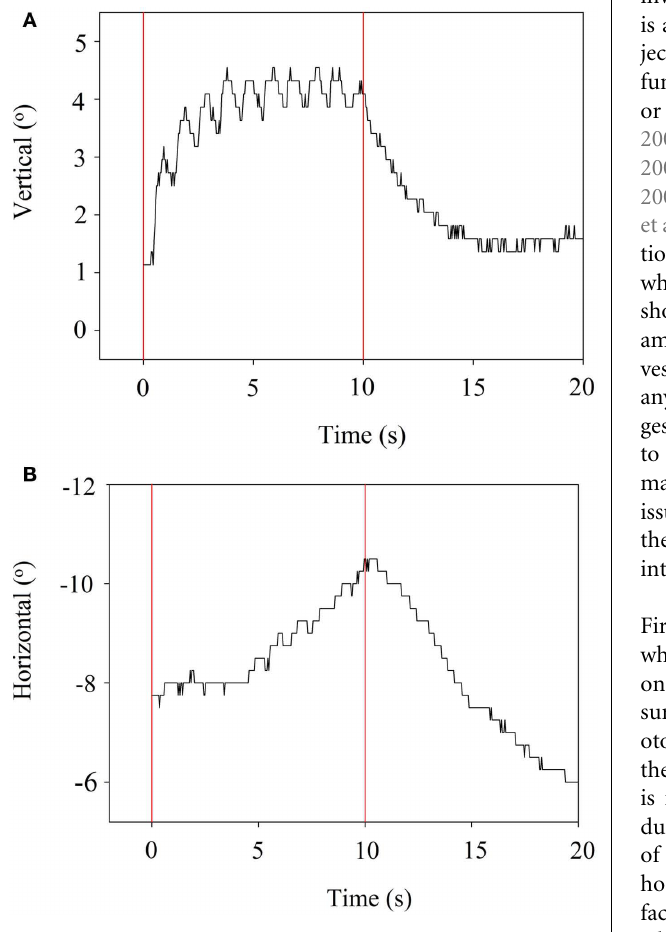
vertical component and a horizontal component away from